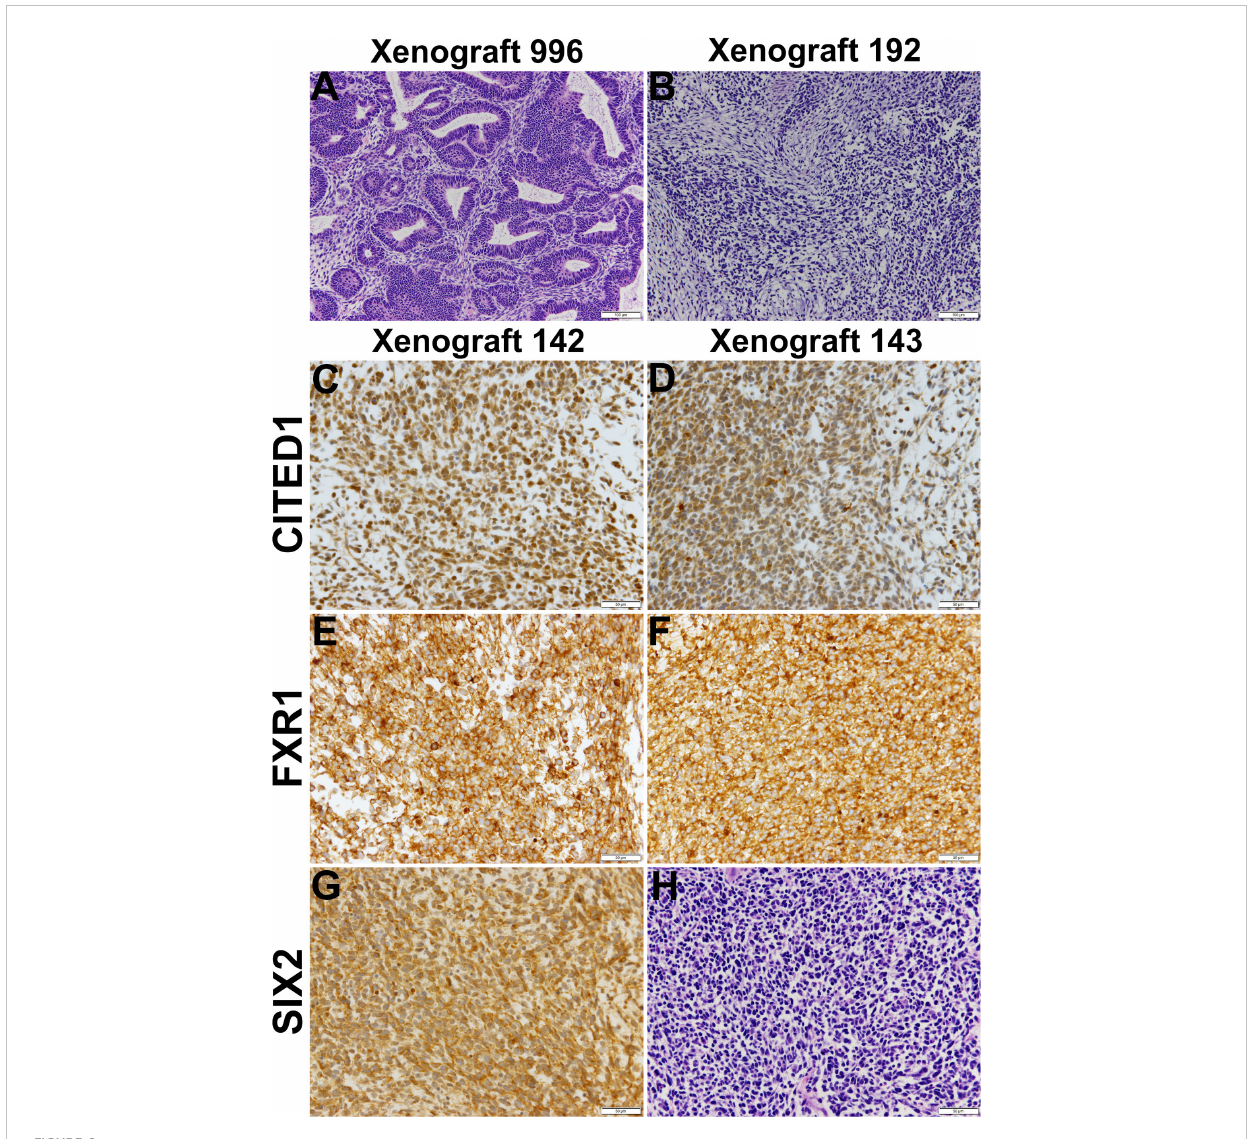
FIGURE 6 This fi gure shows representative histology and immunostaining of VUWT50 cells after culture, then engraftment into subcutaneous tissues of nude mice. (A, B) Hematoxylin and eosin stains of passage 2 (996) and 3 (192) xenografts originating from VUWT50. Each column for either